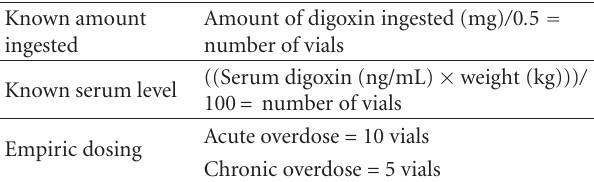
Table 1: Digoxin antibody dosing